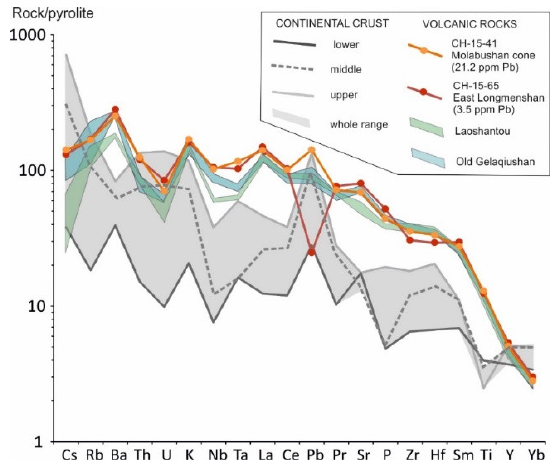
Figure 10. Pyrolite-normalized trace-element patterns of rocks from older flows and key samples of moderate-Mg rocks from the Molabushan cone and East Longmenshan volcano. Samples CH-15-65 and CH-15-41 showed the lowest and highest Pb concentrations, respectively. Typical continental crust compositions are shown for comparison. Normalizing values are after [50] (Pb = 150 ppb), continental crust compositions are after [51].